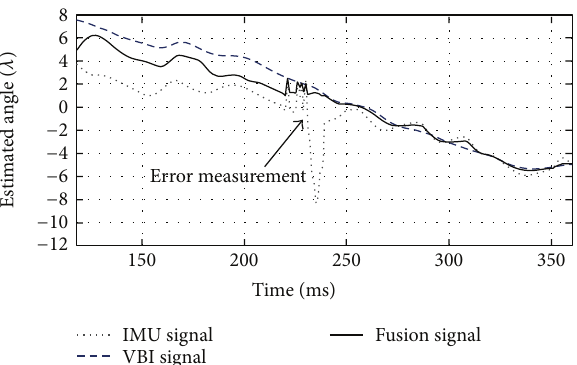
Figure 6: Fusion algorithm and results in laboratory conditions. The angle estimated from the IMU, VBI, and the fusion are tested with nonabrupt and abrupt changes in head’s movements. Between 200 and 300 ms, a measurement outlier is filtered by the fusion